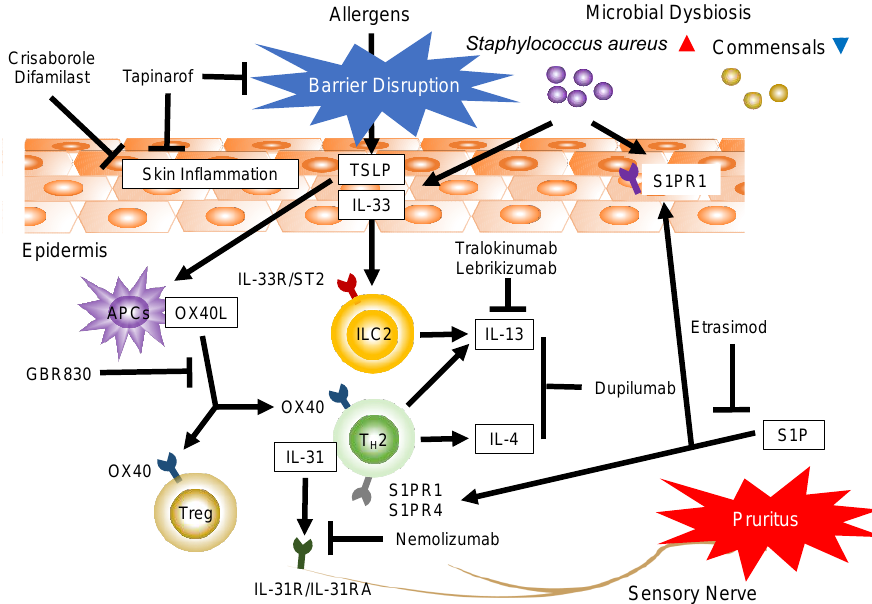
Figure 1. Therapies based on the pathogenesis of atopic dermatitis. Disrupted epidermal barrier function and microbial dysbiosis induce the production of pro-inflammatory mediators. Keratinocyte-produced TSLP and IL-33 enhance type 2 inflammatory responses through the activation of Th2 cells and ILC2s. Th2 cells and ILC2s produce the key inflammatory cytokines (IL-4 and/or IL-13) of AD. The ligation of OX40L and OX40 augments Th2 immune responses. IL-31 is a T cell-derived cytokine associated with pruritus. IL-31 transmits itch sensations via IL-31R in peripheral neurons. The lipid mediator S1P regulates various cell activities, including cell growth, differentiation, apoptosis, migration, inflammation, metabolism, and angiogenesis, through S1PRs. TSLP, thymic stromal lymphopoietin; IL, interleukin; Th, T-helper cells; ILC2s, group 2 innate lymphoid cells; OX40L, OX40 ligand; IL-31R, IL-31 receptor; S1P, sphingosine 1-phosphate.